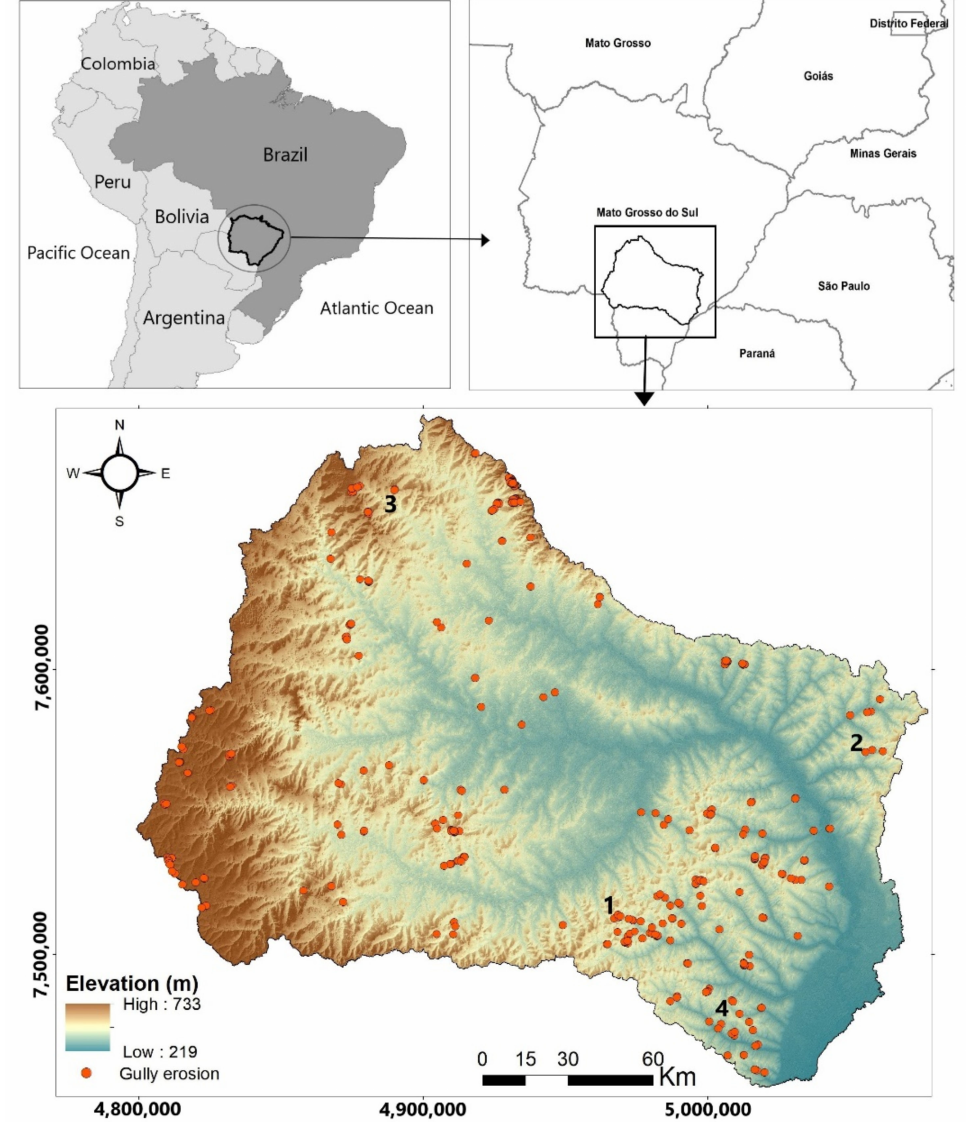
Figure 1. Location of the study area and distribution of gullies (G-points); the black numbers denote some examples of gullies presented in Figure 2. Spatial references SIRGAS_2000_Brazil_Polyconic in